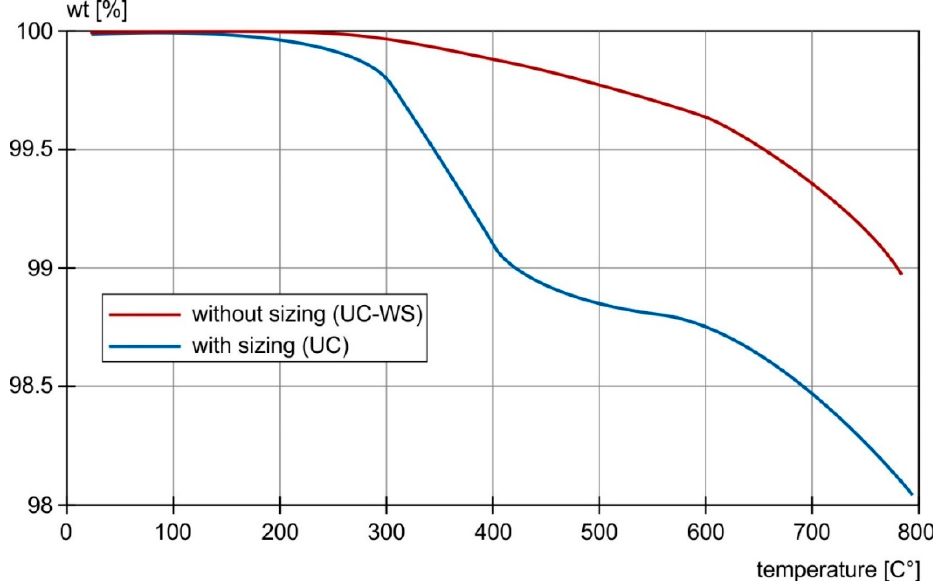
Figure 15. TGA measurement of both unimpregnated Carbons.